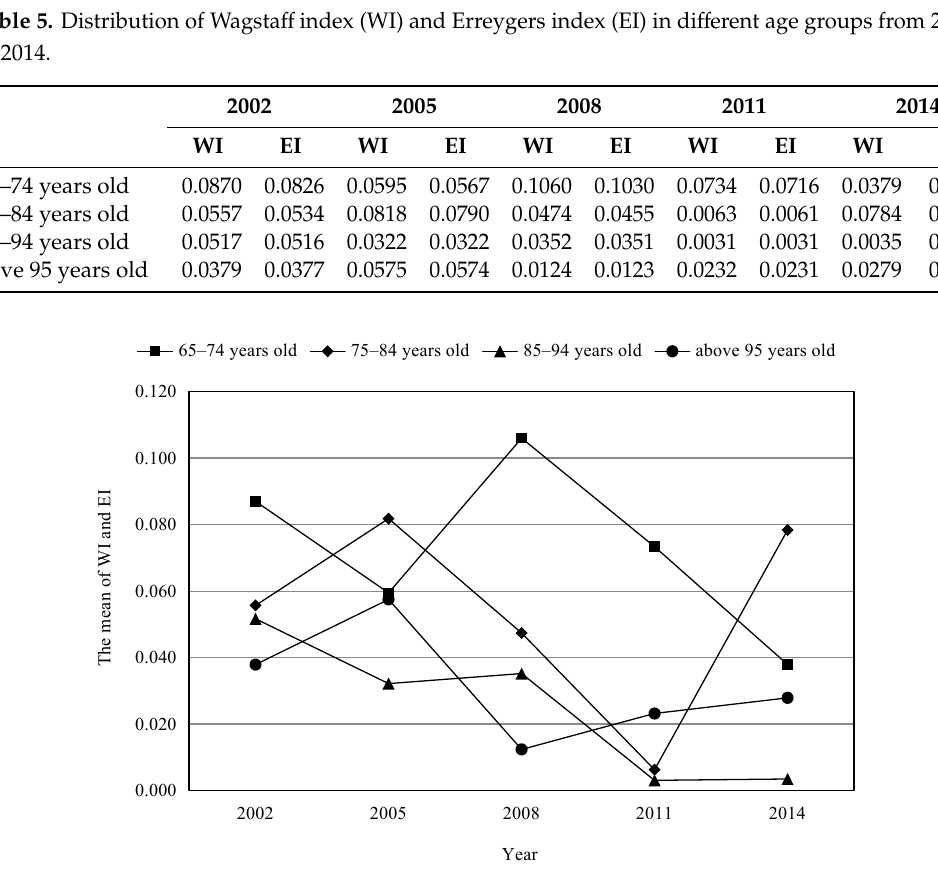
Table 6. Shapley decomposition and recentered influence function-index-ordinary least squares (RIF- I-OLS) decomposition of health inequality among the elderly in rural China.